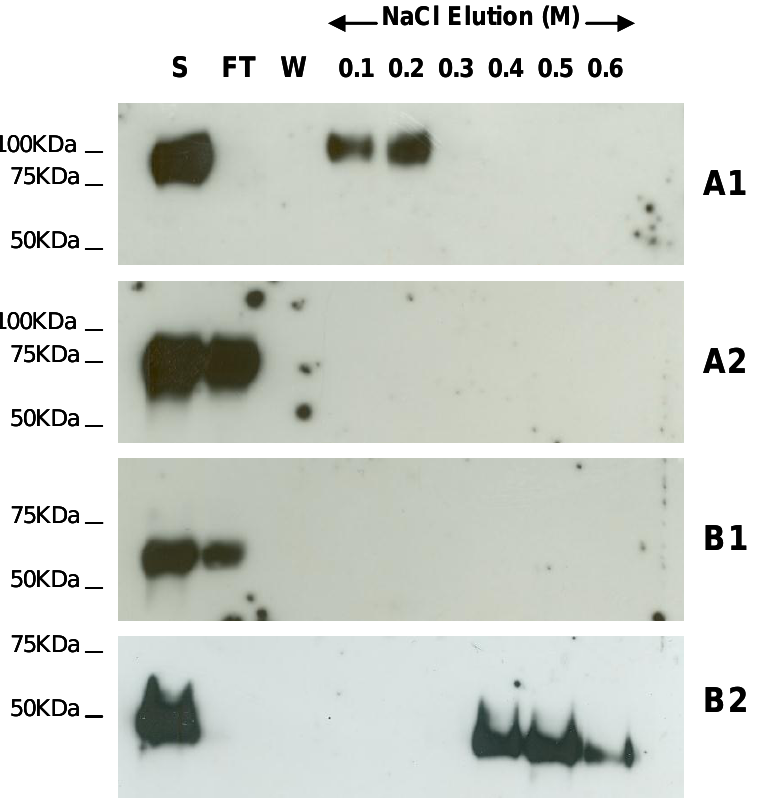
Figure 2. Heparin agarose affinity chromatography of recombinant G ectodomain for A1, A2, B1 and B2 hMPV strains. The start (S), flow through (FT), final wash (W) and salt elution fractions were analyzed by 10% SDS-PAGE under reducing conditions and western blot analysis using anti-c-Myc monoclonal antibody. A1, A2, B1 and B2 indicate the strain type.